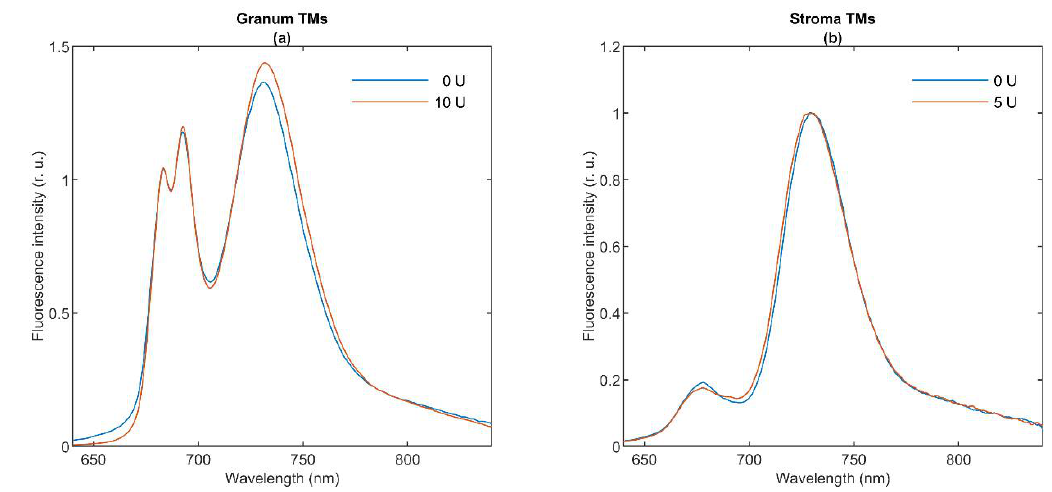
Figure 2. The 77 K fluorescence emission spectra of lipase-treated granum ( a ) and stroma ( b ) thylakoid membranes. Excitation at 435 nm; spectra are normalized at 685 nm (( a ); emission of PSII) and at 730 nm (( b ); emission of PSI). All experiments were performed at 5 °C on dark-adapted samples. Four individual batches of granum TMs were measured and averaged. A single batch of stroma TMs was used. (For further details, see Methods.).